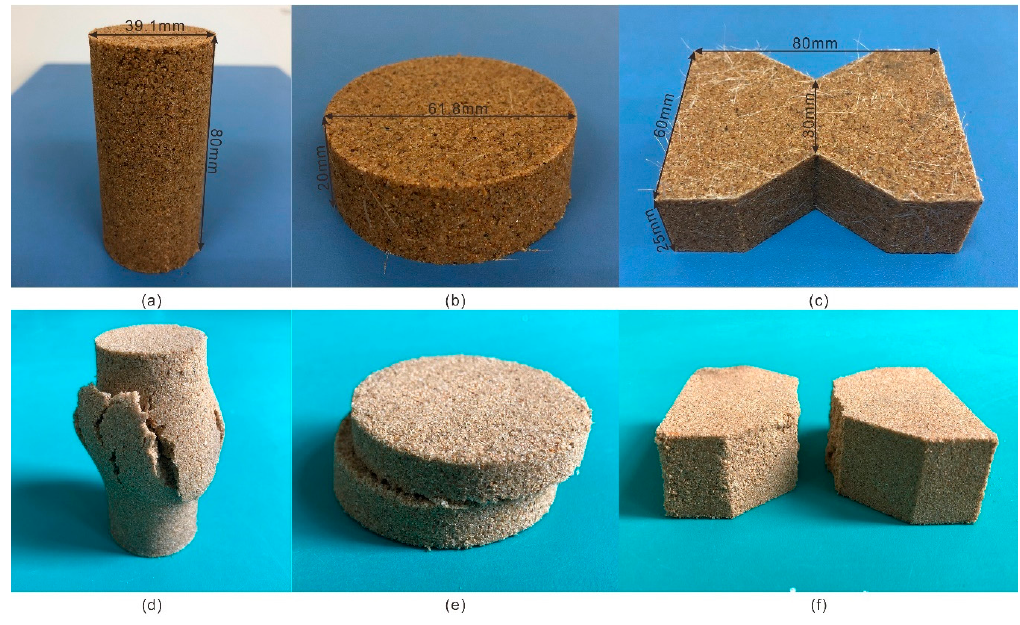
Figure 3. Photographs of compacted and broken specimens: ( a ) Compacted unconfined compression test specimen; ( b ) Compacted direct shear test specimen; ( c ) Compacted tensile test specimen; ( d ) Broken unconfined compression test specimen; ( e ) Broken direct shear test specimen; ( f ) Broken tensile test